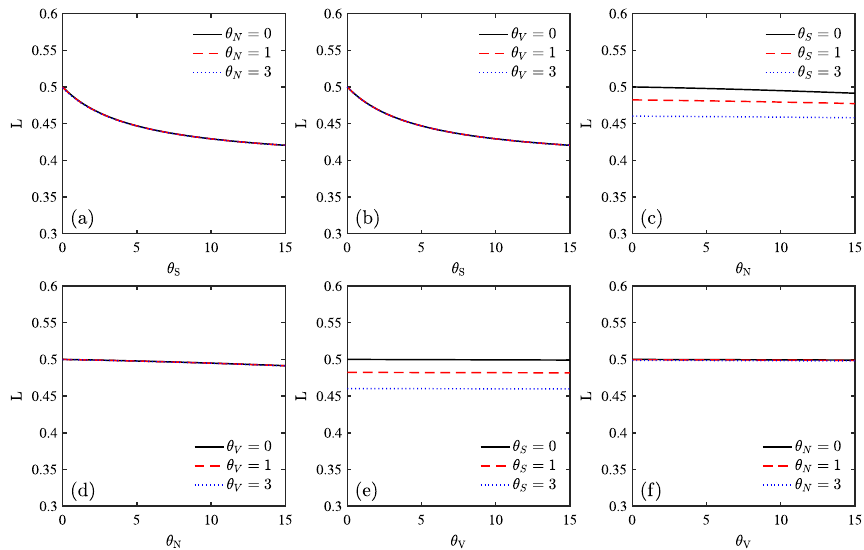
Fig. 10 Expected utility loss in cryptocurrency market as a function of the investor’s ambiguity parameters θ S , θ V and θ